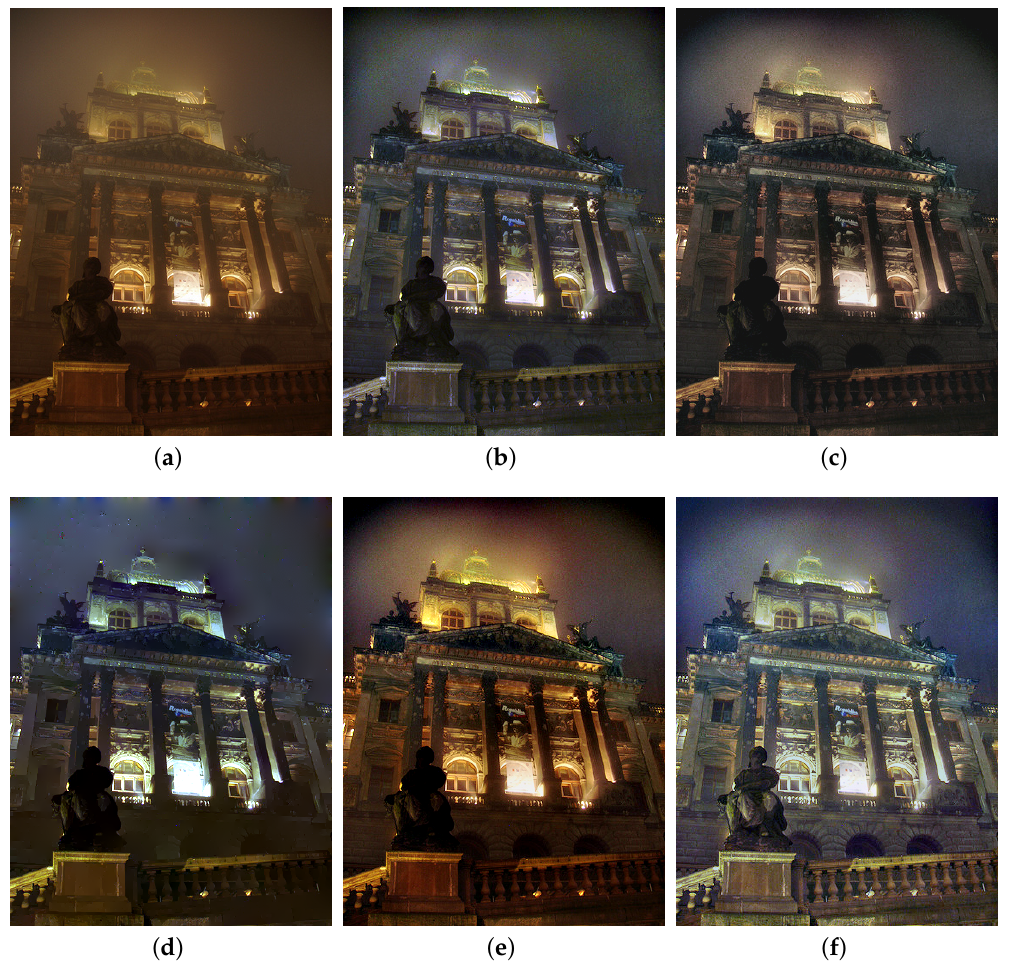
Figure 12. Comparisons with other nighttime dehazing methods on test image Church